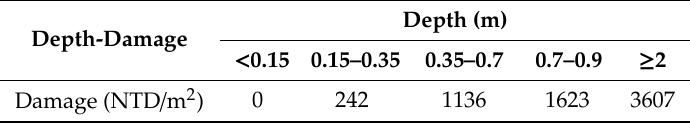
Table 1. Depth-damage table for the residential area from the field survey.